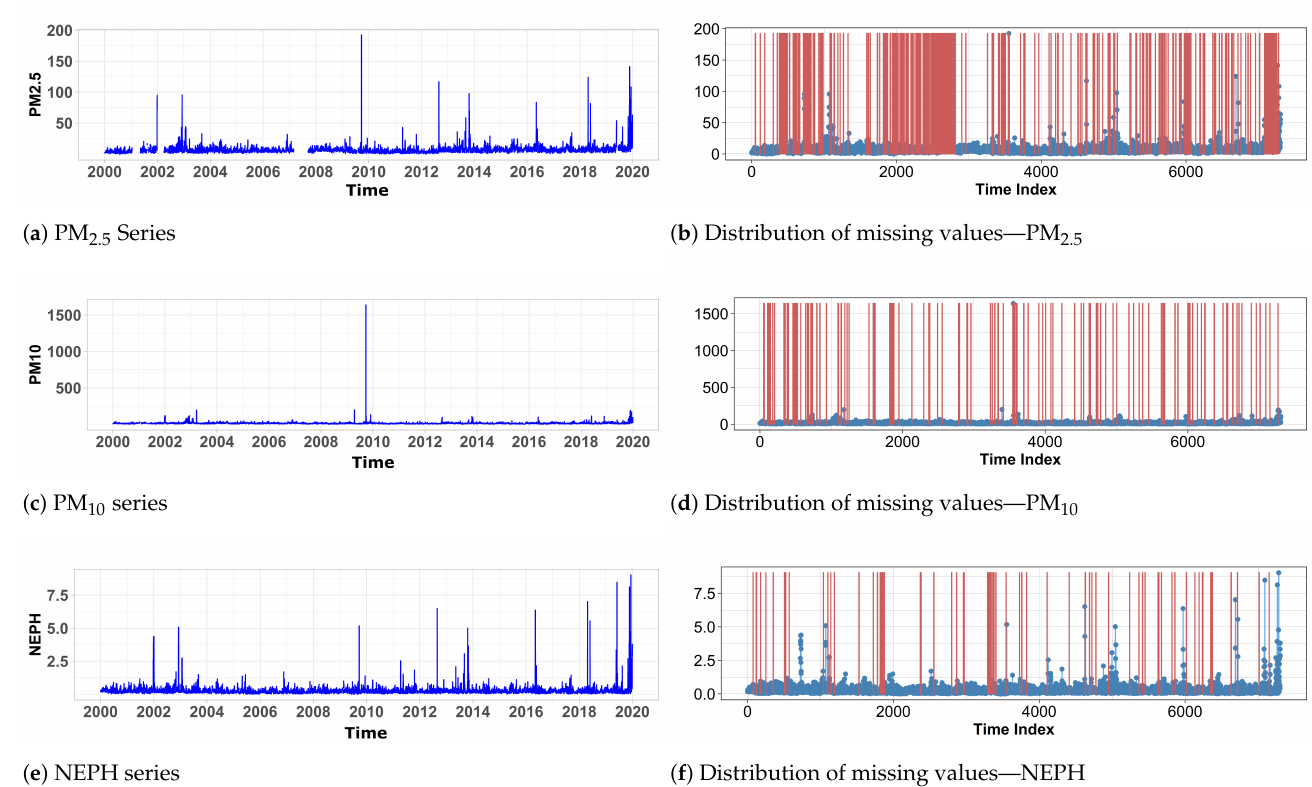
Figure 6. Distribution of missing values of the variables PM 2.5 , PM 10 , and NEPH: Left-hand figures ( a , c , e ) show the original time series whereas Right-hand figures ( b , d , f ) show the distribution of missing values with red lines representing the positions of missing values and blue lines representing the original